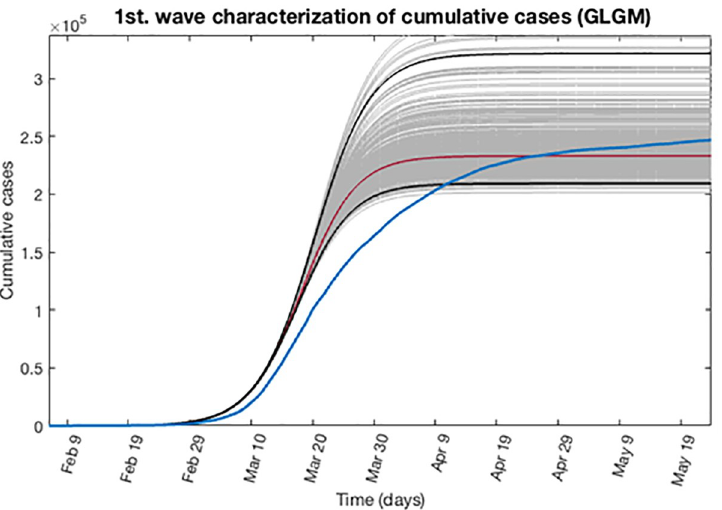
Fig 8. Characterization of the cumulative epidemic profile for the first wave using GLGM. The solid blue line is the cumulative number of cases; red line corresponds to the best fit of the GLGM to the data. Grey lines correspond to the m bootstrapping realizations of the epidemic curves. Black lines correspond to the 95% CI bounds.